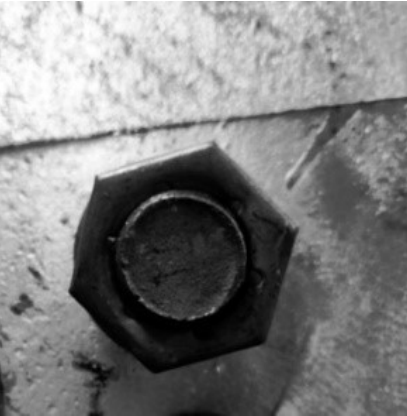
Figure 8. Image enhancement effect.